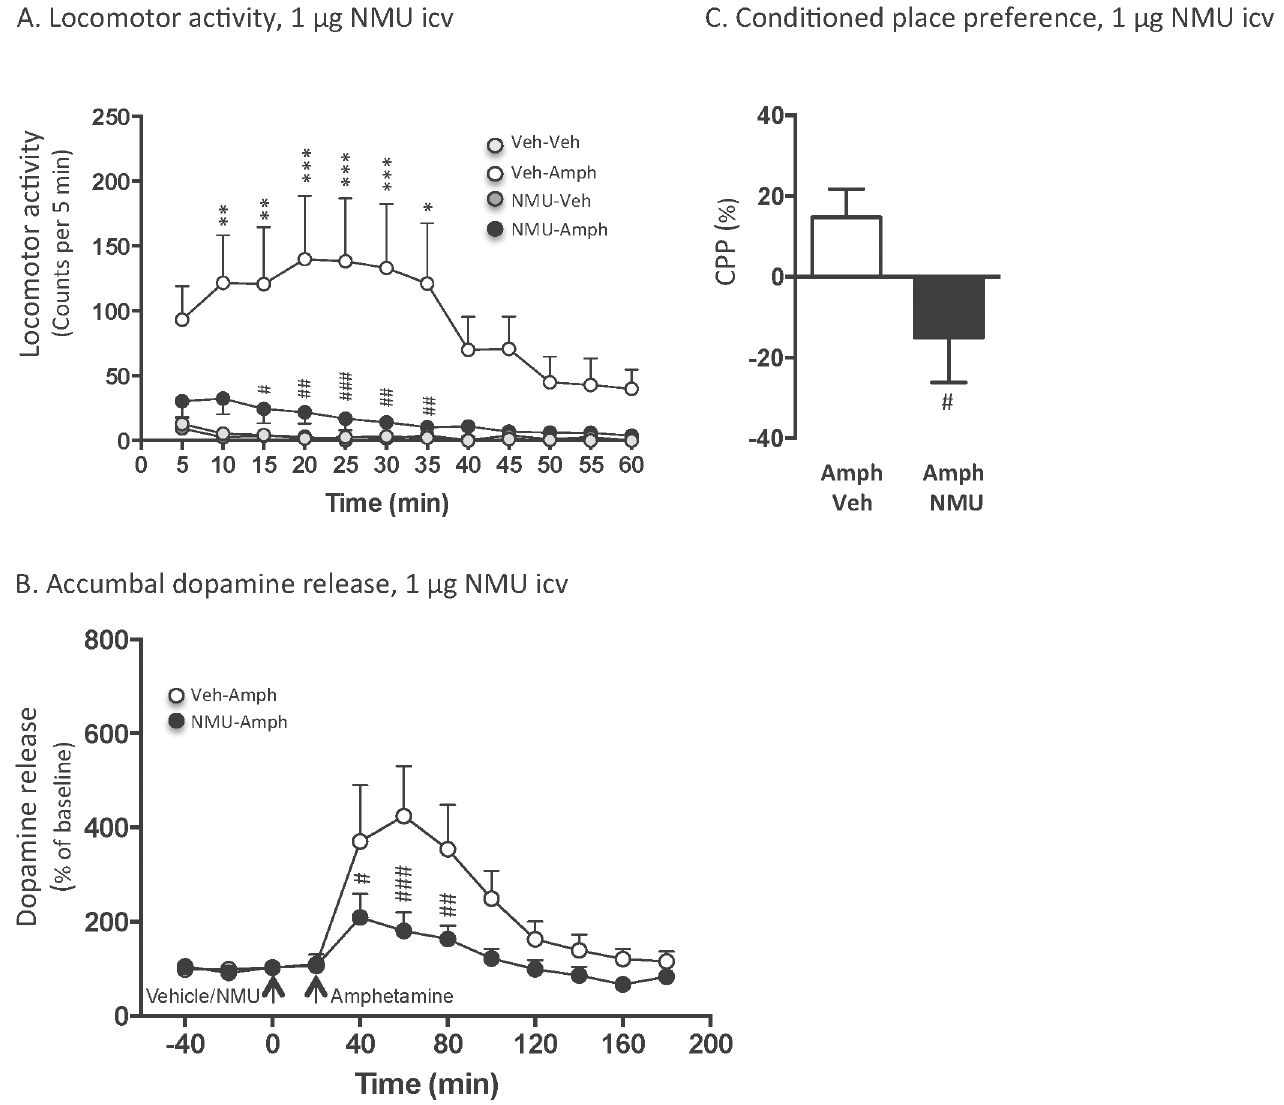
Fig 2. Central (1 μ g, icv) administration of NMU attenuates amphetamine-induced locomotor stimulation, accumbal dopamine release and expression of conditioned place preference in mice. (A) Amphetamine-induced (2 mg/kg, ip) locomotor stimulation was blocked by a central injection of NMU (1 μ g, icv) at time point 15 – 35 minutes. Central NMU administration had no effect per se on locomotor activity. (B) NMU (1 μ g, icv) attenuated amphetamine (2 mg/kg, ip) induced increase in accumbal dopamine release at time point 40 – 80 minutes. (C) Central NMU (1 μ g, icv, Amph-NMU) administration prevented the amphetamine (2 mg/kg, Amph-Veh) induced expression of conditioned place preference (CPP). Data are presented as mean ± SEM ( * P < 0.05, ** P < 0.01, *** P < 0.001 for Veh-Veh versus Veh-Amph and # P < 0.05, ## P < 0.01, ### P < 0.001 for Veh-Amph versus